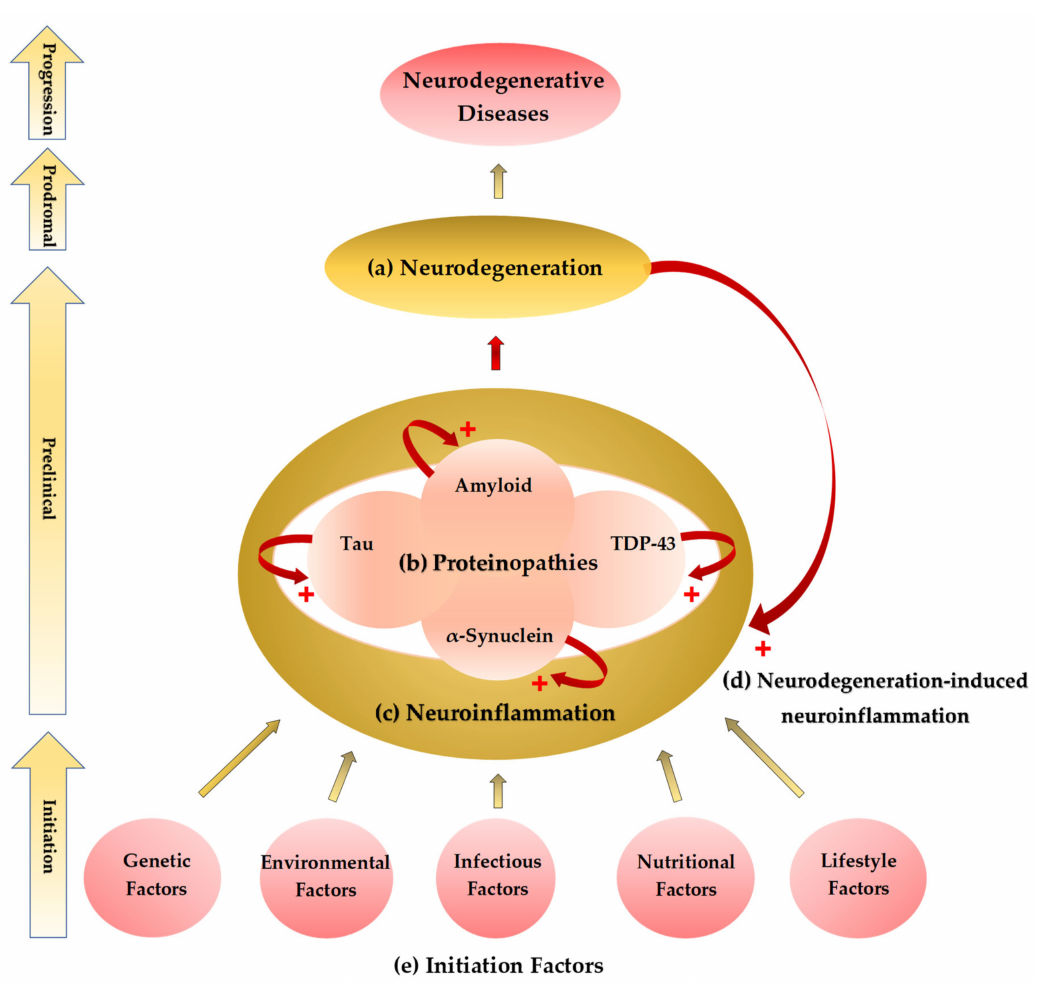
Figure 1. Initiation–progression hypothesis of neurodegenerative diseases. ( a ) A common pathological finding of neurodegenerative diseases (NDs) is neurodegeneration such as neural loss and gliosis. The location and distribution of neurodegeneration present corresponding neurological and psychiatric signs and symptoms. ( b ) Histopathological studies showed abnormal proteinaceous deposits in the degenerative neural tissues. Proteinopathies include amyloidosis, tauopathy, synucleopathy, and transactive response DNA-binding protein (TDP)-43 proteinopathy. ( c ) Activation of glial cells and astrocytes causes neuroinflammation, most probably the last common pathway leading to neurodegeneration. Neuroinflammation potentiates the accumulation of the abnormal proteinaceous materials in the brain tissue. ( d ) Neurodegeneration also causes neuroinflammation forming a cyclic potentiation. ( e ) The proteinopathy–neuroinflammation–neurodegeneration cycle can be triggered by multifactorial initiation factors not yet clearly defined. The genetic, environmental, infectious, nutritional, and lifestyle components are major factors which contribute to the initiation process of the